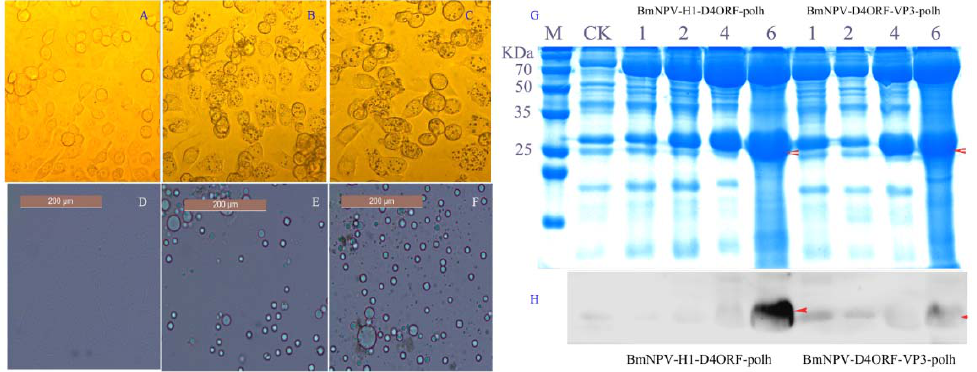
Figure 2. H1-D4ORF, D4ORF-VP3, and BmCPVpolh expressed in the BmN cells and silkworm larvae. ( A ) The uninfected BmN cells; ( B ) BmCPV polyhedra were observed in cells transfected with Bacmid-H1-D4ORF-polh; ( C ) BmCPV polyhedra were observed in cells transfected with Bacmid-D4ORF-VP3-polh; ( D ) BmCPV polyhedra were not found in the hemolymph of uninfected silkworm larvae; ( E ) BmCPV polyhedra generated in the hemolymph of infected silkworm larvae with BmNPV-H1-D4ORF-polh; ( F ) BmCPV polyhedra generated in the hemolymph of infected silkworm larvae with BmNPV-D4ORF-VP3-polh; ( G ) SDS-PAGE of the hemolymph from silkworm larvae infected with BmNPV-H1-D4ORF-polh/BmNPV-D4ORF-VP3-polh. Lane M, protein marker; lane CK, the hemolymph of uninfected silkworm larvae; lane 1, 2, 4, and 6, the hemolymph of silkworm larvae infected with BmNPV-H1-D4ORF-polh/BmNPV-D4ORF-VP3-polh 1, 2, 4, and 6 days post-infection. The recombinant proteins areindicated by an arrowhead; ( H ) Western blot analysis depicting the hemolymph of silkworm larvae infected with BmNPV-H1-D4ORF-polh/BmNPV-D4ORF-VP3-polh. Mouse anti-ORF72 (1:500) was used as the primary antibody and an HRP-conjugated goat anti mouse IgG (1:20,000) was used as the second antibody. The signal bands representing recombinant proteins are indicated by an arrowhead.